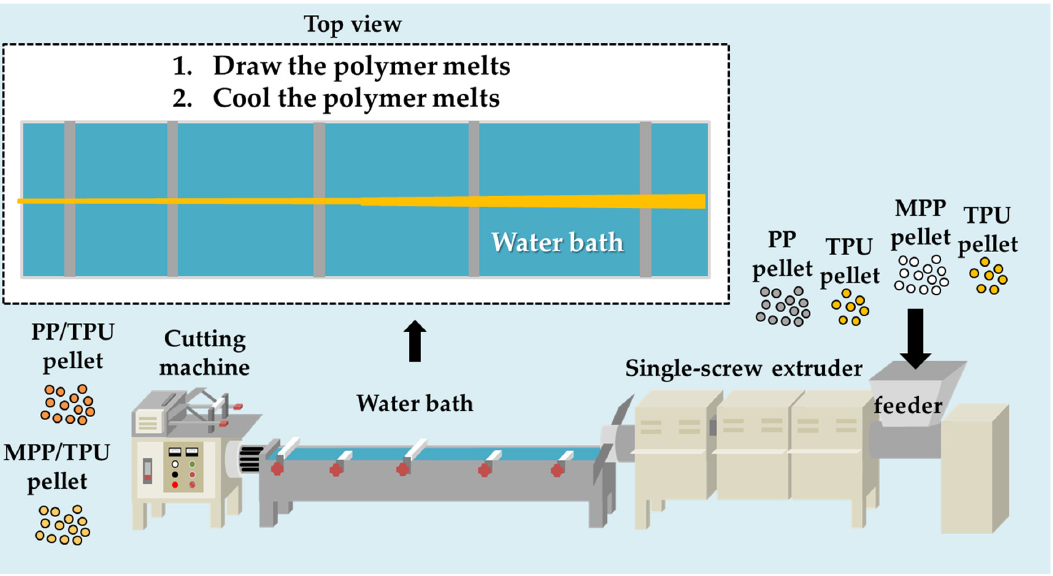
Figure 1. Schematic diagram of the manufacturing process. PP: polypropylene; MPP: modified impact ‐ resistant polypropylene; TPU: thermoplastic polyurethane.